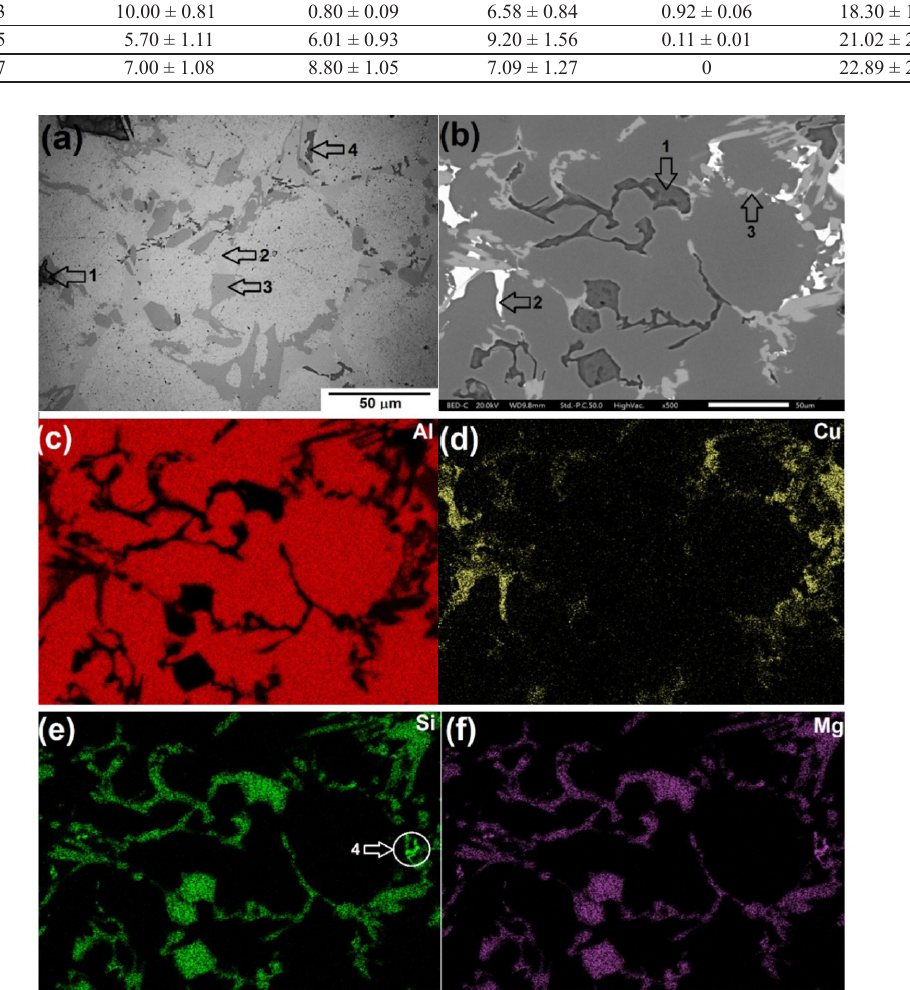
Figure 3. OM (a) and BE-SEM (b) micrographs of the experimental alloys with Cu content of 5%, and EDX-mappings corresponding to Al (c), Cu (d), Si (e) and Mg (f). Arrows indicate second phases: (1) Mg